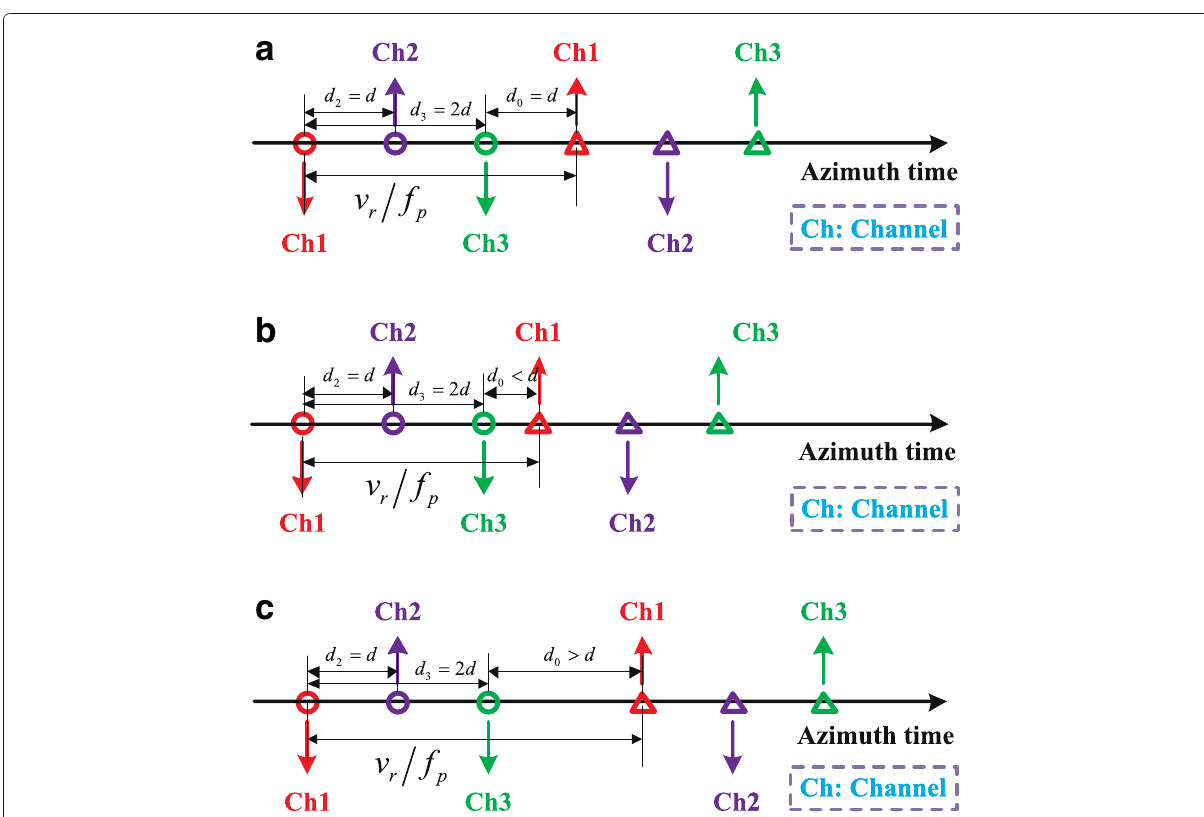
Fig. 2 Different azimuth sampling schemes for multichannel SAR regarding the positions of EPCs. a Uniform-sampling, κ = 1. b Over-sampling, κ > 1. c Under-sampling, κ < 1. Here, the channel number is 3, and d 1 = 0. Besides, the triangles and circles stand for the sampling positions